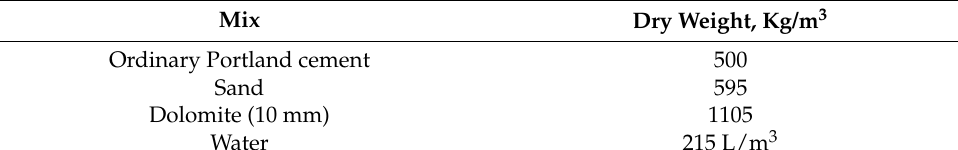
Table 3. Concrete mix design (normal-strength concrete with f c (cid:48) = 30 MPa).